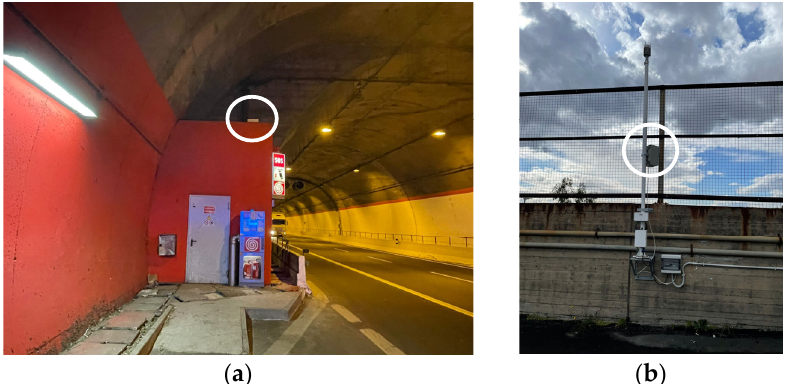
Figure 3. ( a ) The emergency area of the Galleria San Demetrio where the MONICA IoT sensor node has been installed (in the white circle); ( b ) the MONICA installed in an emergency area on the viaduct (in the white circle).